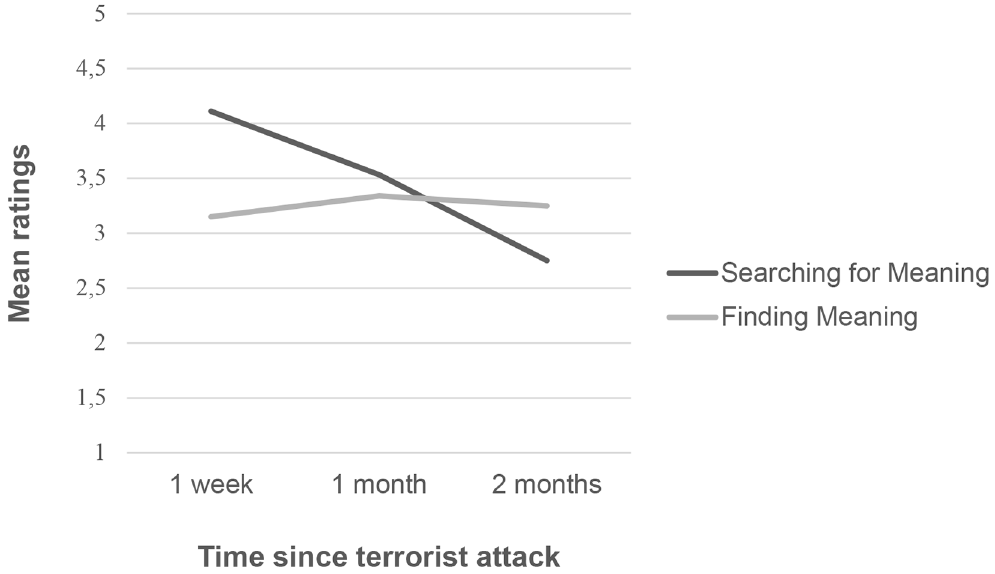
Figure 1. Mean levels of searching for meaning and finding meaning at three measurement times.